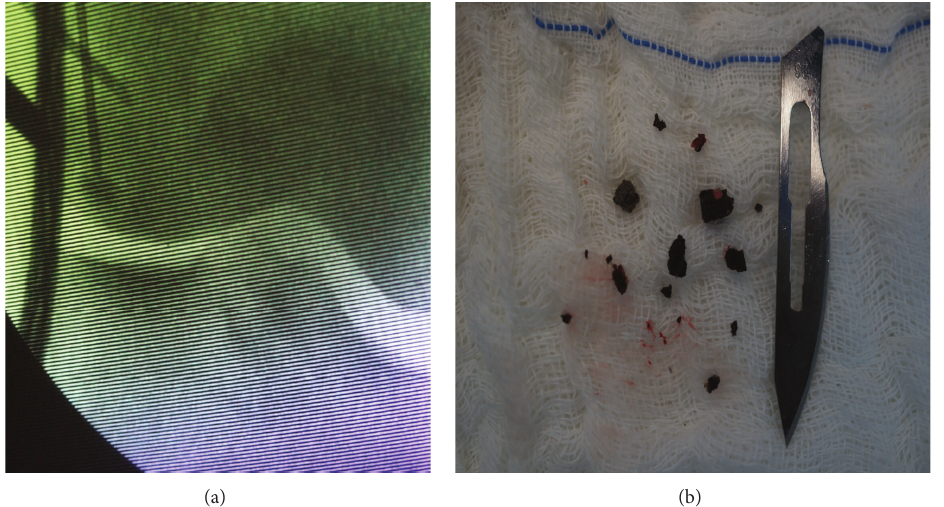
Figure 2: Intraoperative fluoroscopy image showing access to the foreign body via medial surgical (a) and image of the fragment removed after surgery